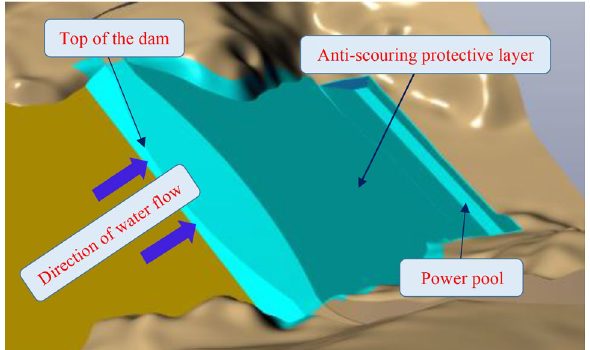
Figure 8. Full coverage technology for the anti-scouring protective layer.